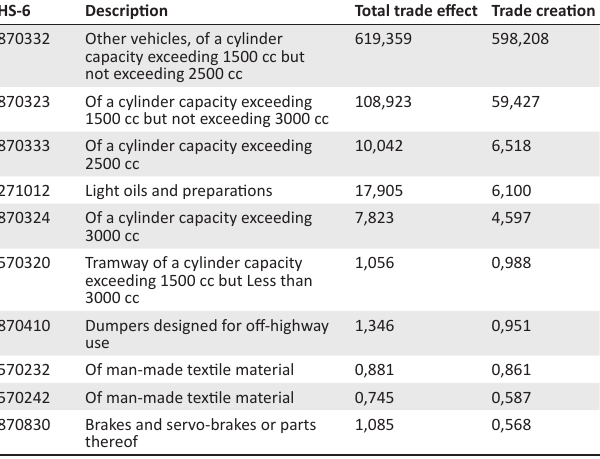
TABLE 3: Top 10 products with highest trade creation effects on South Africa (US$ 000).